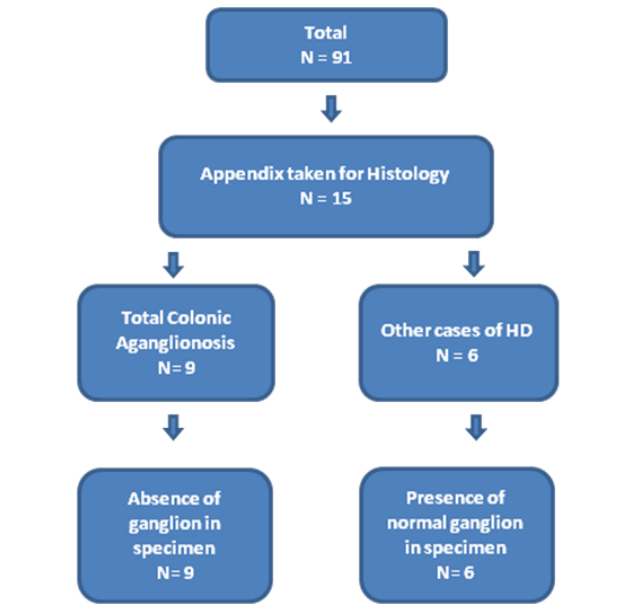
Figure 1: Flow chart outlining the distribution of all cases of Hirschsprung’s disease and histological analysis of appendix.